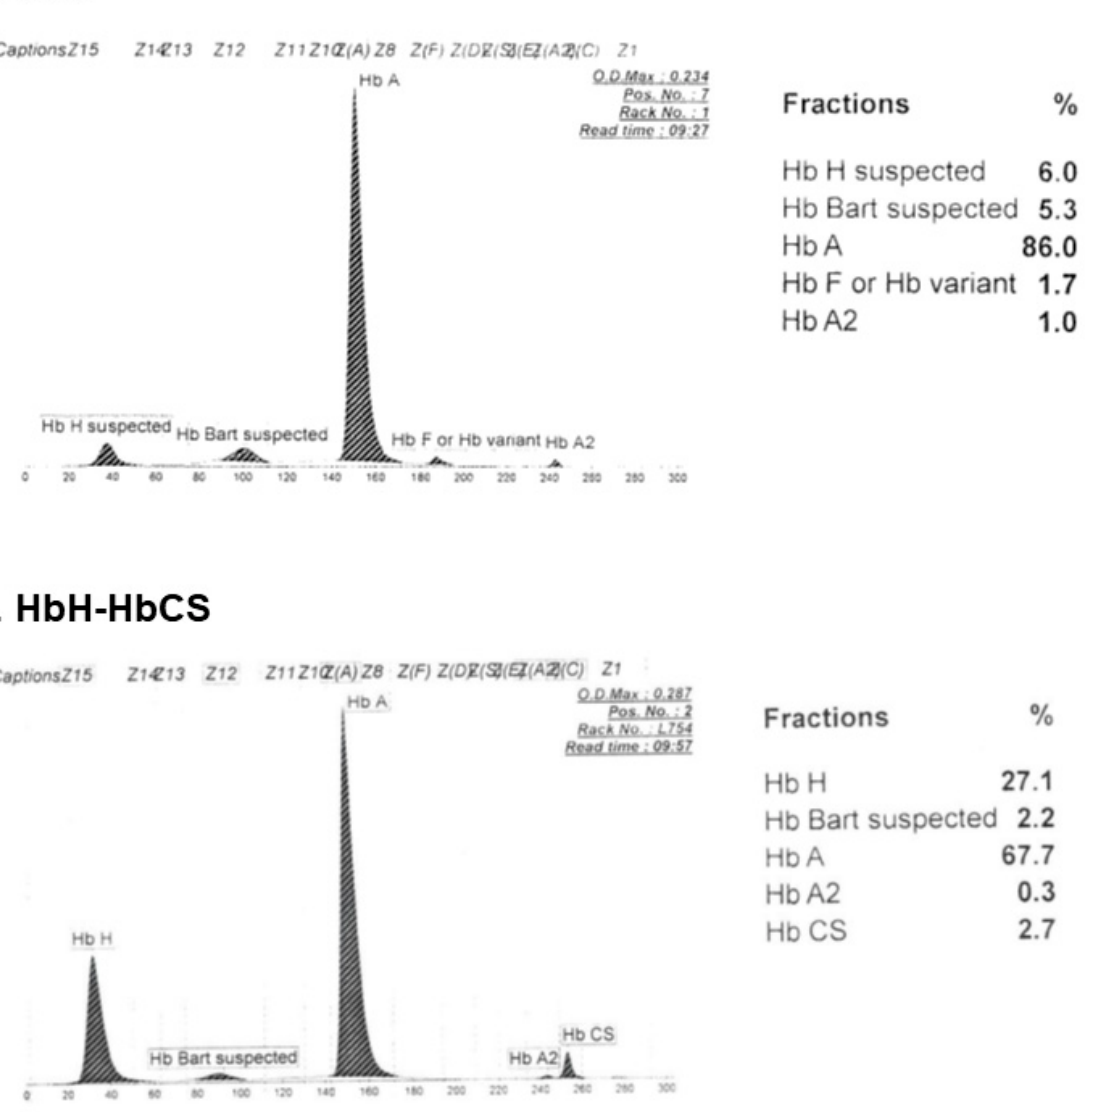
Figure 1. Typical hemoglobin analysis of patients with HbH ( A ) and HbH-HbCS ( B ) by automated high-performance liquid chromatography system.